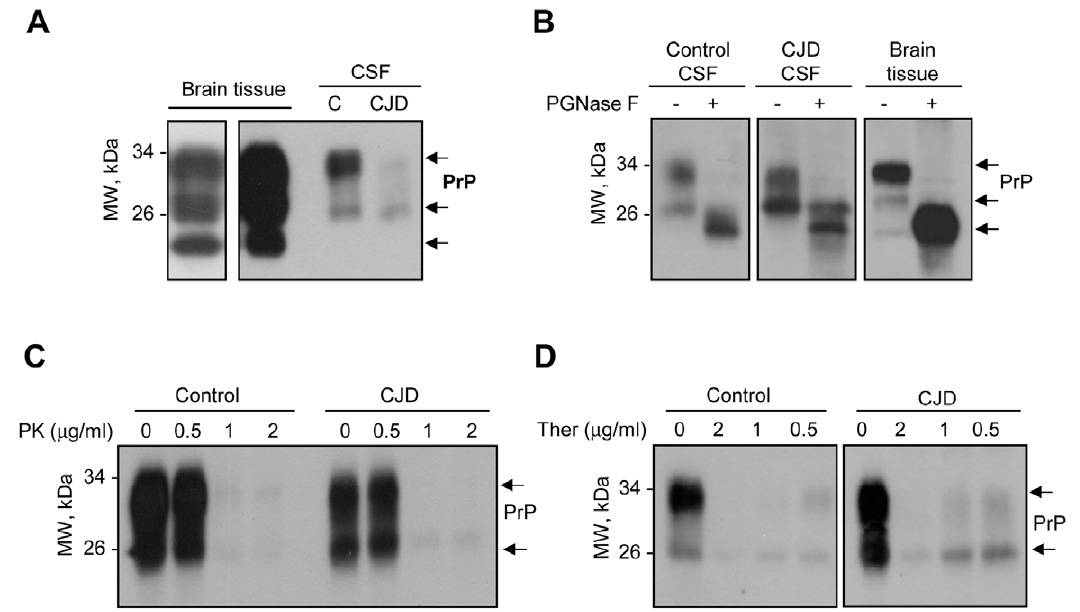
Figure 4. Changes in the glycosylation pattern of PrP in CSF of CJD patients. A. The pattern of expression of PrP in two representative CSF samples (from one healthy control individual and one CJD patient) is compared to the PrP pattern observed in control brain tissue using Western blot analysis. B. CSF samples from one healthy control individual, one CJD patient and one healthy control brain tissue were treated with PNGase F and then analyzed by Western blot. Data represent the analysis of three control and five individual CJD samples. C. and D. CSF samples from one healthy control individual and one CJD patient were treated with various concentrations of PK or thermolysin (Ther), respectively, followed by Western blot analysis. Data represent the analysis of three control and five individual CJD samples.